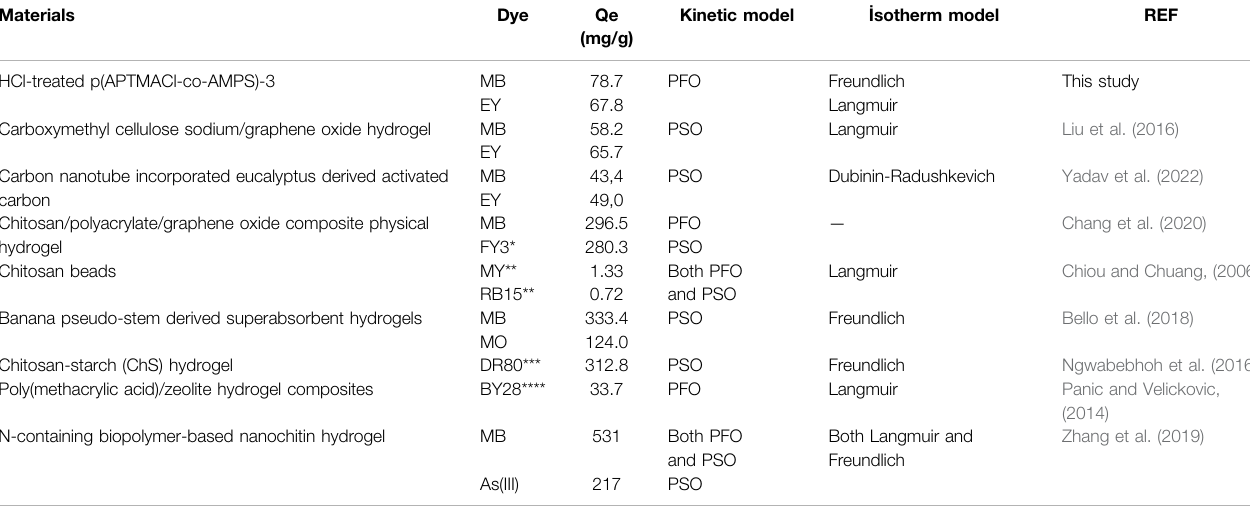
TABLE 3 | Comparison of q e (mg/g), adsorption kinetics, and adsorption type of HCl-treated p (APTMACl-co-AMPS)-3 hydrogels with reported other materials.